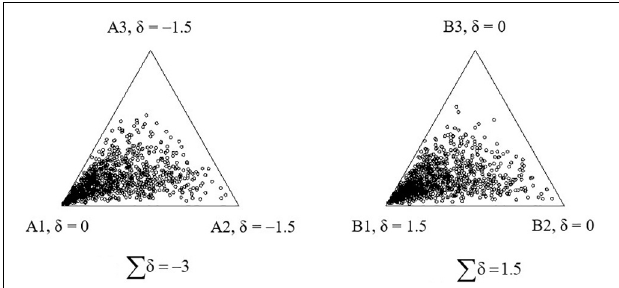
FIGURE 3 | The 1,000 replications of a single person’s responses to the two compositional items, δ A = [0, − 1.5, − 1.5] and δ B = [1.5, 0, 0], under the lognormal